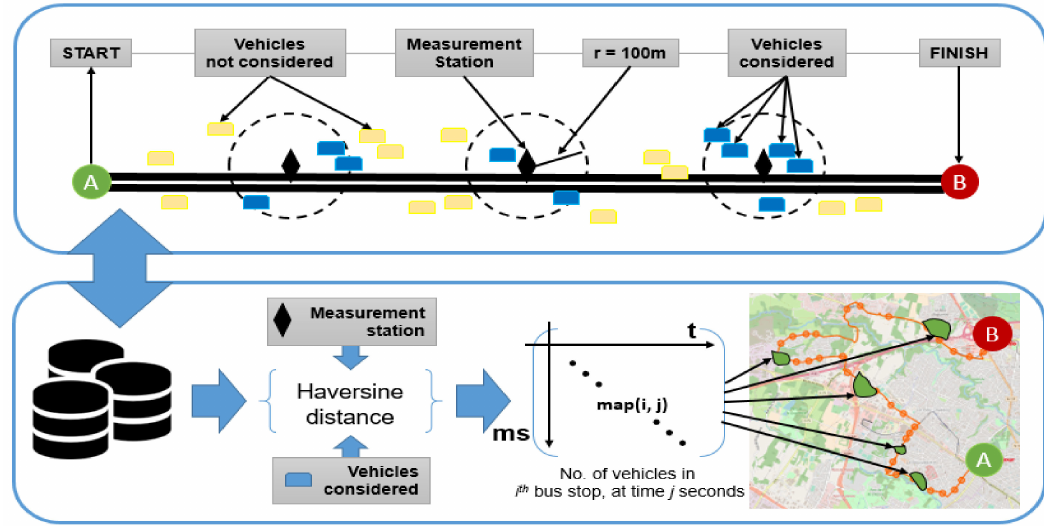
Figure 24. Neural network approach for public transportation prediction